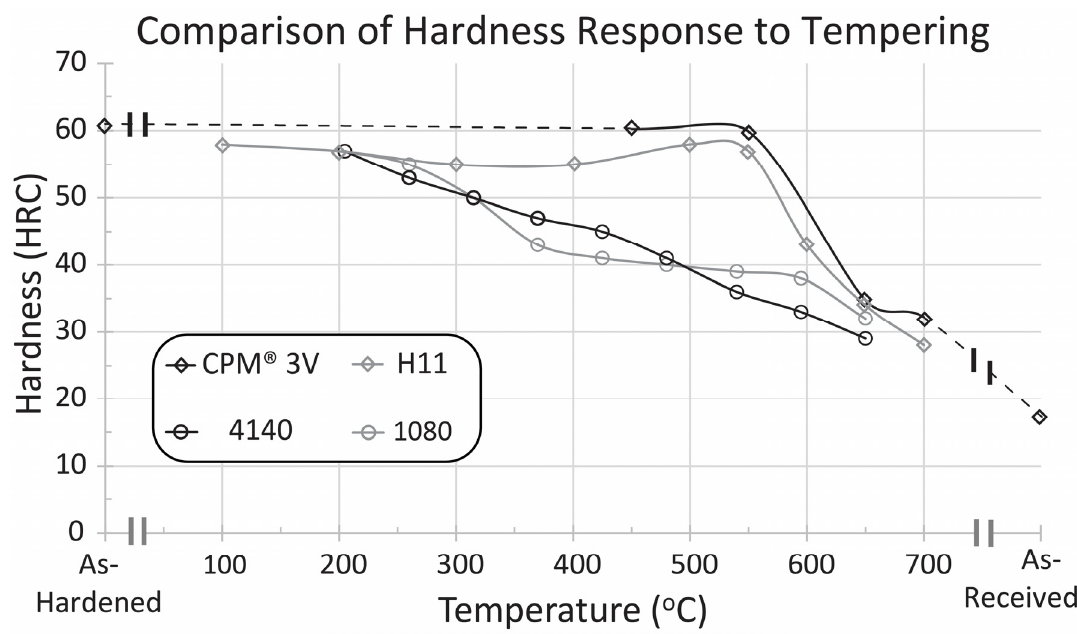
Figure 9. Comparison of HRC vs. tempering temperature response of CPM ® 3V, H11, 4140, and 1080 steels. CPM ® 3V hardness data is from this study; 1080, 4140, H11 hardness data is from [8]. Table 3. Composition of CPM ® 3V measured using Arc/Spark OES. H11, 4140, 1080 compositions for tempering response comparison; compositions from published literature [31–33].